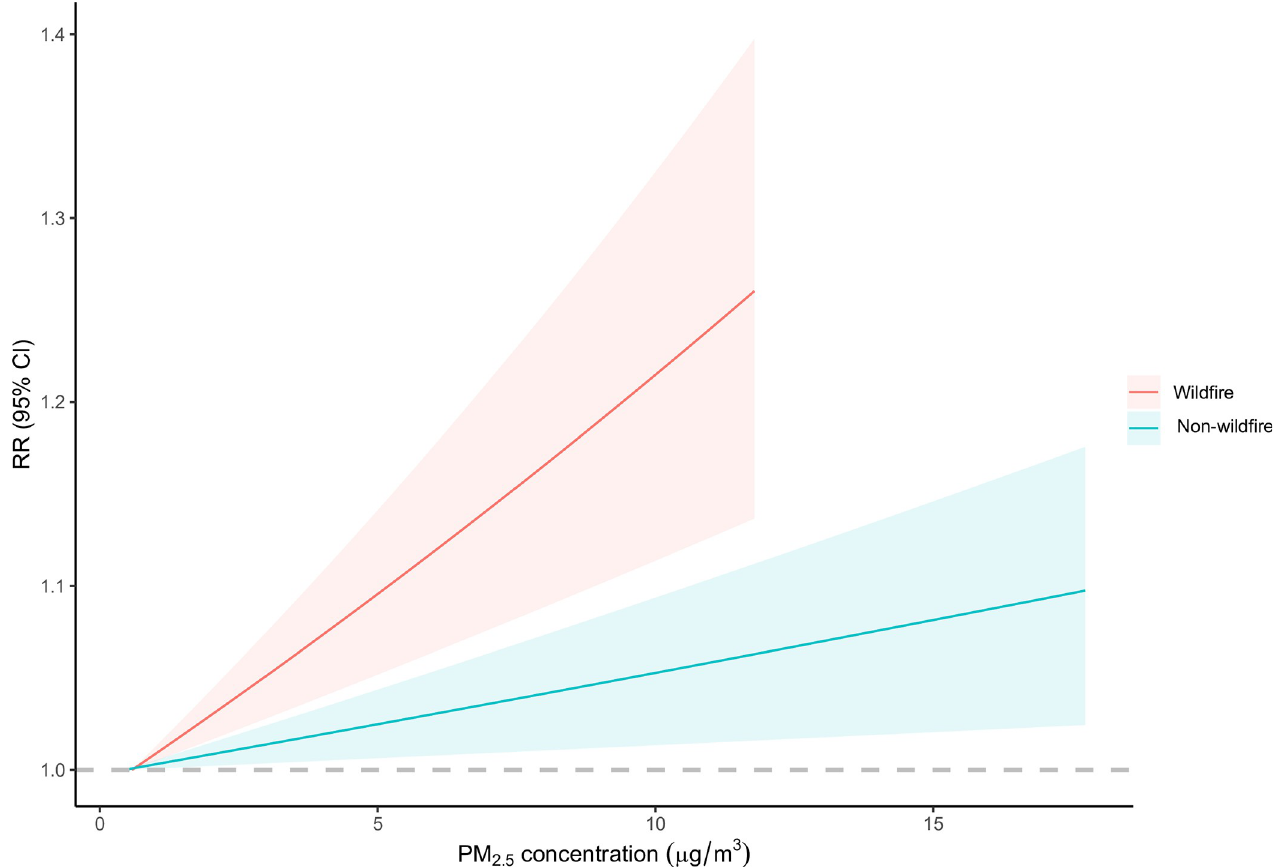
Fig 2. Estimated RR (95% CI) for the association between a 1- μ g/m 3 increase in lag0–1-year wildfire-related PM 2.5 , and non-wildfire-related PM 2.5 and cancer mortality for 2010–2016. AU : PleasecheckthattheeditstothetitleforFig 2 captureyourmeaning : Ifnot ; pleaseeditasnecessary : The solid lines represent the RR, and the shaded areas represent the 95% CI. The model, AU : InthelegendtoFig 2 : Pleasecheckthattheeditstothesentence } Themodel ::: } captureyourmeaning : Ieditedthissentencethesameinallfigureandsupportingfigurelegendswherethissentenceappeared : Ifthisiswordingisnotcorrect ; pleaseprovidecorrectwordinginalllocations : by its design, controlled for factors that were stable across the study period or had similar trend across geographical locations, and also adjusted for spatial-temporal factors including seasonal temperature and GDP per capita. CI, confidence interval; RR, relative risk.